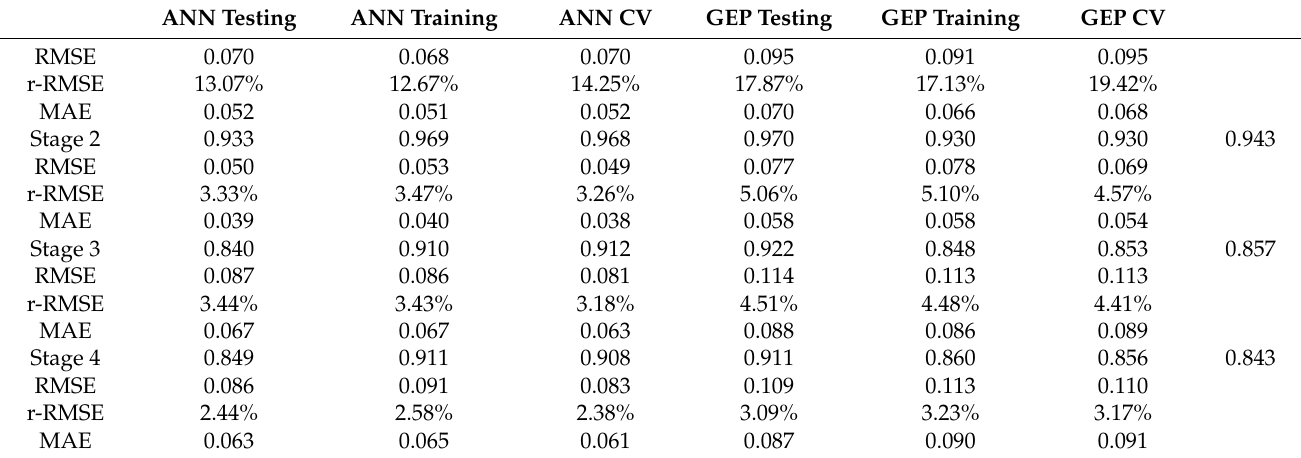
Table 4. Gene expression programming (GEP), ANN RSME, and MAE